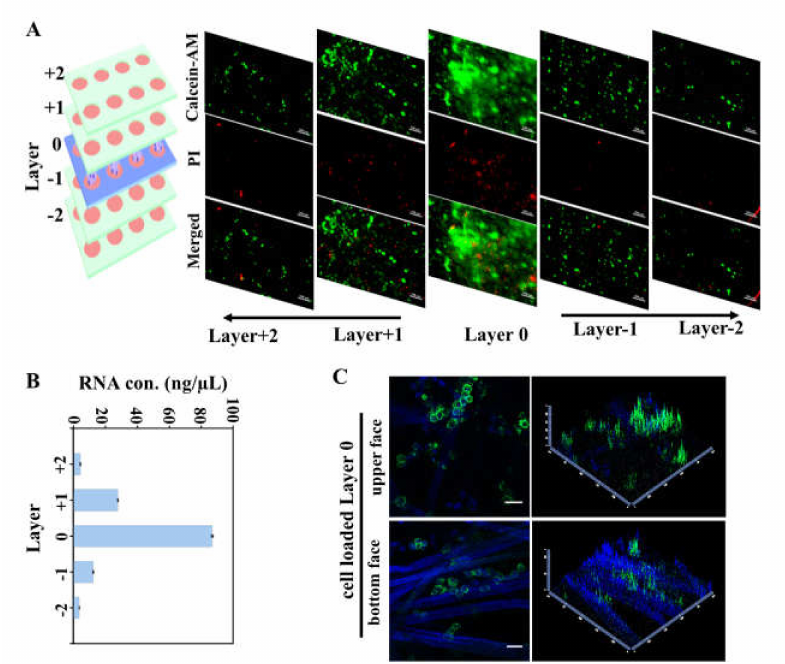
Figure 3. Separation and isolation of cells according to their motility. ( A ) Fluorescent image of cells migrated into different layers of the CiGiP cell migration platform. Prostate cancer DU 145 cells were loaded at the middle layer (Layer 0) of the invasion platform. After seven days culturing, the CiGiP platform was de-stacked. Cells at different layers were stained with Calcein-AM/PI kit. Calcein-AM stains live cell, while PI stains dead cells. Scale bar: 100 µ m. ( B ) RNA concentration isolated from cells invaded into different layers of the CiGiP cell invasion platform. ( C ) Confocal microscopy image of cell seeding layer. Eight microliters of cell/Matrigel mixture was spotted into each zone of the seeding layer. The paper sheet was incubated at 37 ◦ C for 12 h. Then the cells on paper sheet was stained with Calcein-AM. The upper face and bottom face of the paper sheet were examined under confocal microscopy (LSM800, Zeiss, Munich, Germany). The 2D images (left panel) were converted into 2.5-D images (right panel) by confocal software Zen. Scale bar: 50 µ